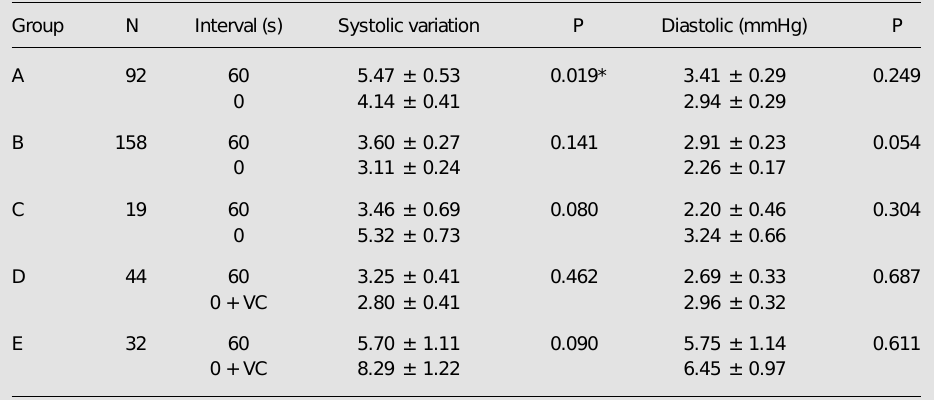
The other comparison was among mean changes in pairs of blood pressure measurements with a 60-s interval versus no interval and venous congestion interposed. Variation is reported as the mean of standard deviation (mmHg) ± mean error. The readings were obtained from the right arm. VC: venous congestion interposed. *P<0.05 comparing groups with and without interval (bilateral t -test for